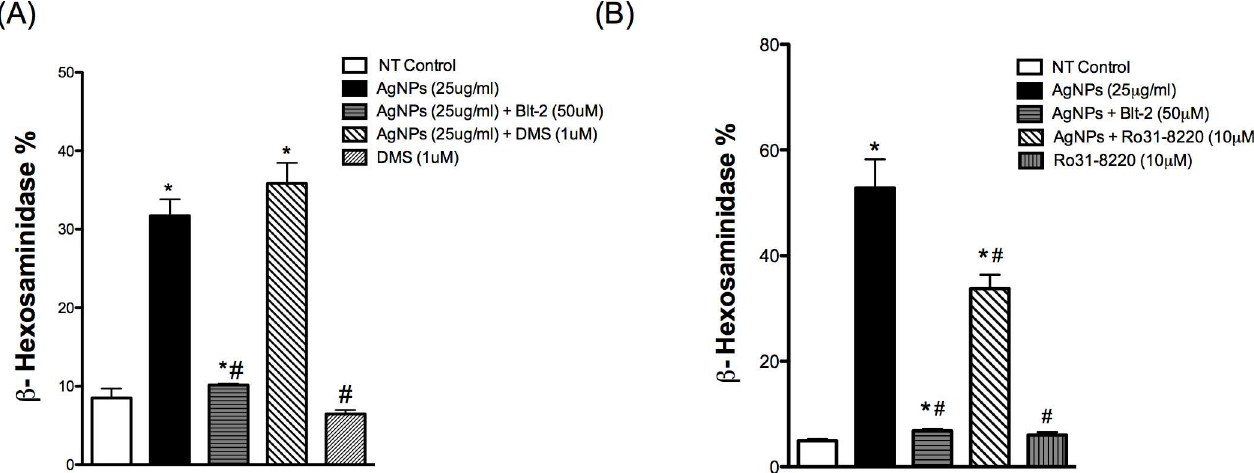
Fig 5. Involvement of other signaling pathways in response to AgNPs Mast cell degranulation was assessedby measuring the release of β - hexosaminidase into supernatants. Cells were pre-treatedwith (A) the sphingosine kinase inhibitor DMS (1 μ M) or (B) the PKC inhibitor Ro31-8220 (10 μ M) for 30 min prior to AgNP (25 μ g/ml) exposurefor 1 h and release of β -hexosaminidasewas assessed. Values are expressedas mean ± SEM of at least 3 independentexperiments. * Indicatessignificantdifference from controlled group (p (cid:20) 0.05). #Indicatessignificant difference from AgNP-treated group (p (cid:20)